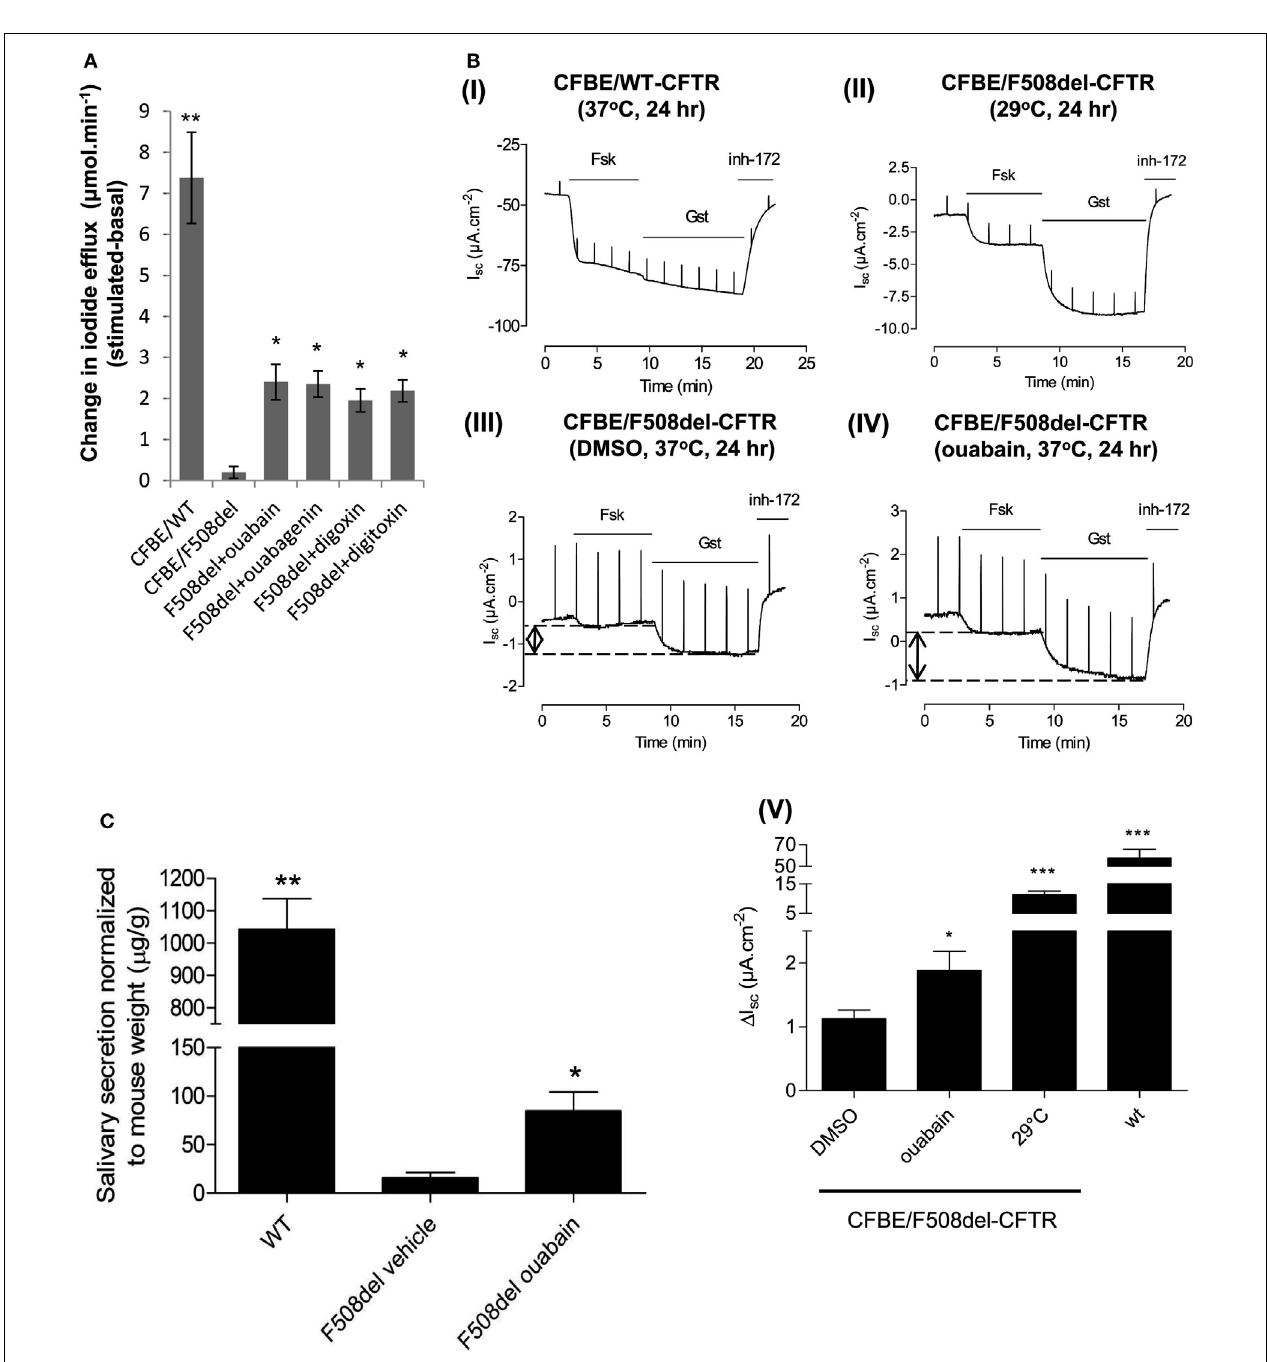
between the sustained phase of the current response after stimulation and the baseline immediately before stimulation. In the bar graph, data, are presented as mean ± SEM as compared to DMSO control [ (I) n = 9 for CFBE/WT-CFTR cells; (II) n = 6 for 29˚C treatment samples; (III) n = 8 for DMSO control; (IV) n = 7 for ouabain; (V) * P < 0.05; *** P < 0.001]. (C) Salivary secretion in wild-type mice (WT) or F508del-CFTR (F508del) mice treated with vehicle alone or 0.01mg/kg/day of ouabain for 2days. Monitored for 30min following stimulation, results are expressed as the mean ± SEM of n = 5 (* P < 0.04; ** P <